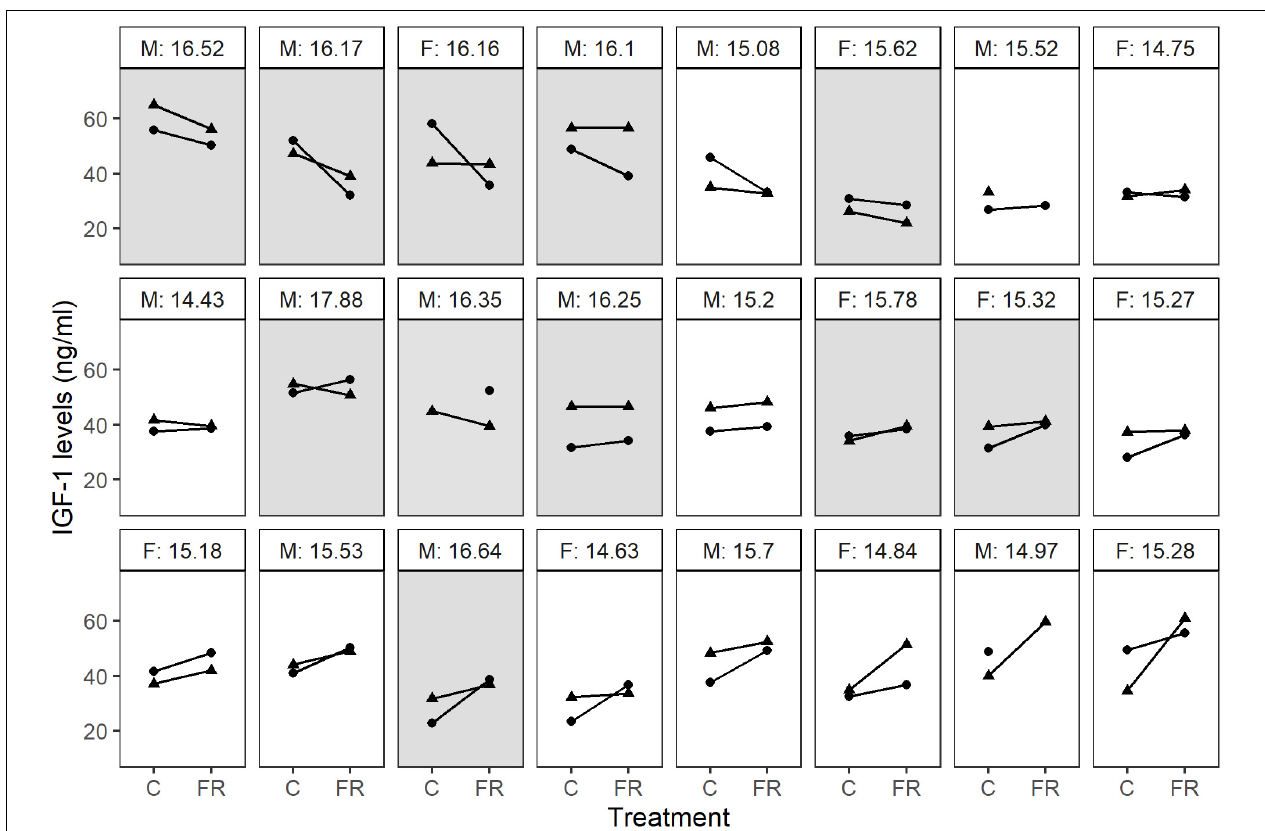
FIGURE 4 | IGF-1 reaction norms in response to food restriction show large among-individual variation. Each panel represents an individual; dots or triangles connected by a line denote IGF-1 levels measured after control (C) or food-restricted (FR) treatment during the first and the second half of the experiment (week 1: dots, week 2: triangles). The text above the panel show the sex (M: males, F: females) and the average body mass (g) for each individual. Light and dark panels indicate individuals lighter and heavier than the median mass of their sex, respectively. For three individuals, one of the samples are missing.